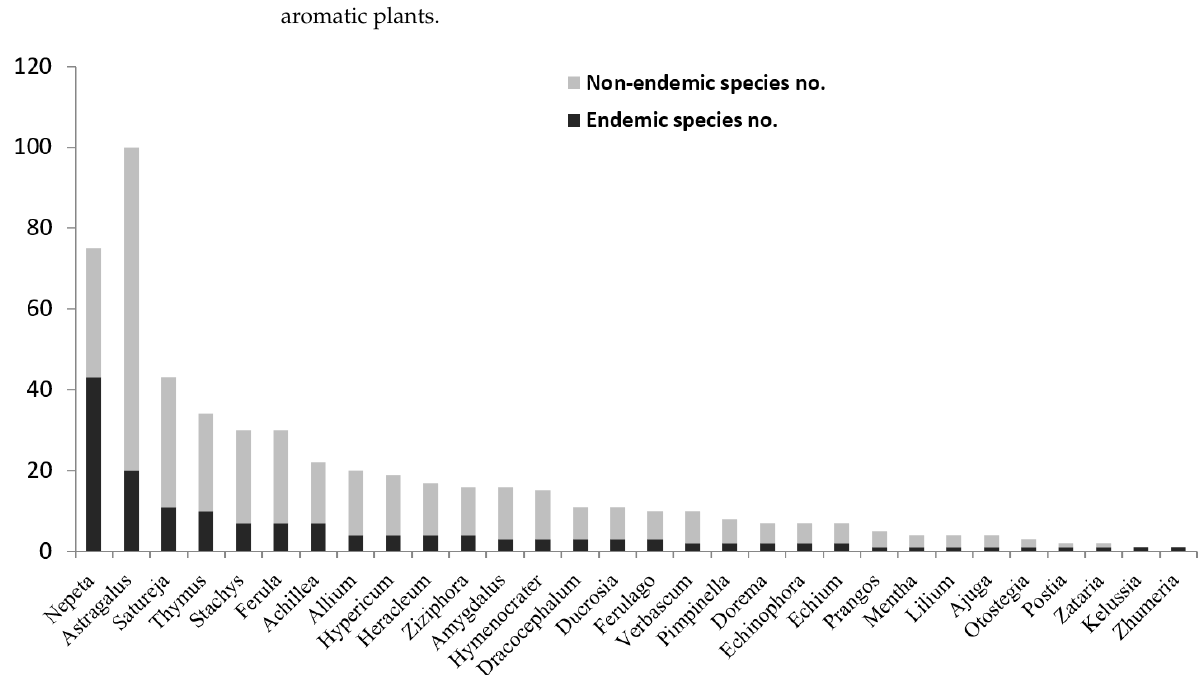
Figure 1. The species number of the ten most endemic-rich families of Iranian medicinal and aro- matic plants.